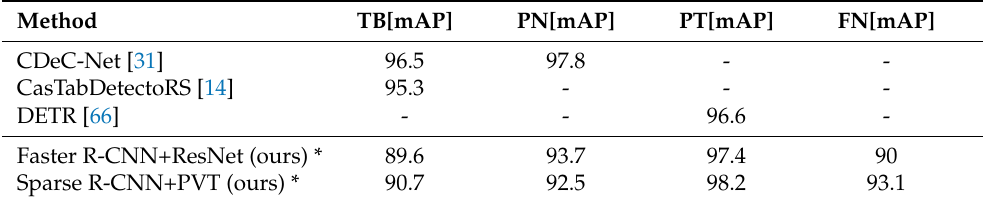
Table 4. The mAP results of SOTA methods and our continual methods. * indicates that the results are not directly comparable. Acronyms TB, PN, PT, and FN denote TableBank, PubLayNet, PubTables-1M, and FinTabNet,